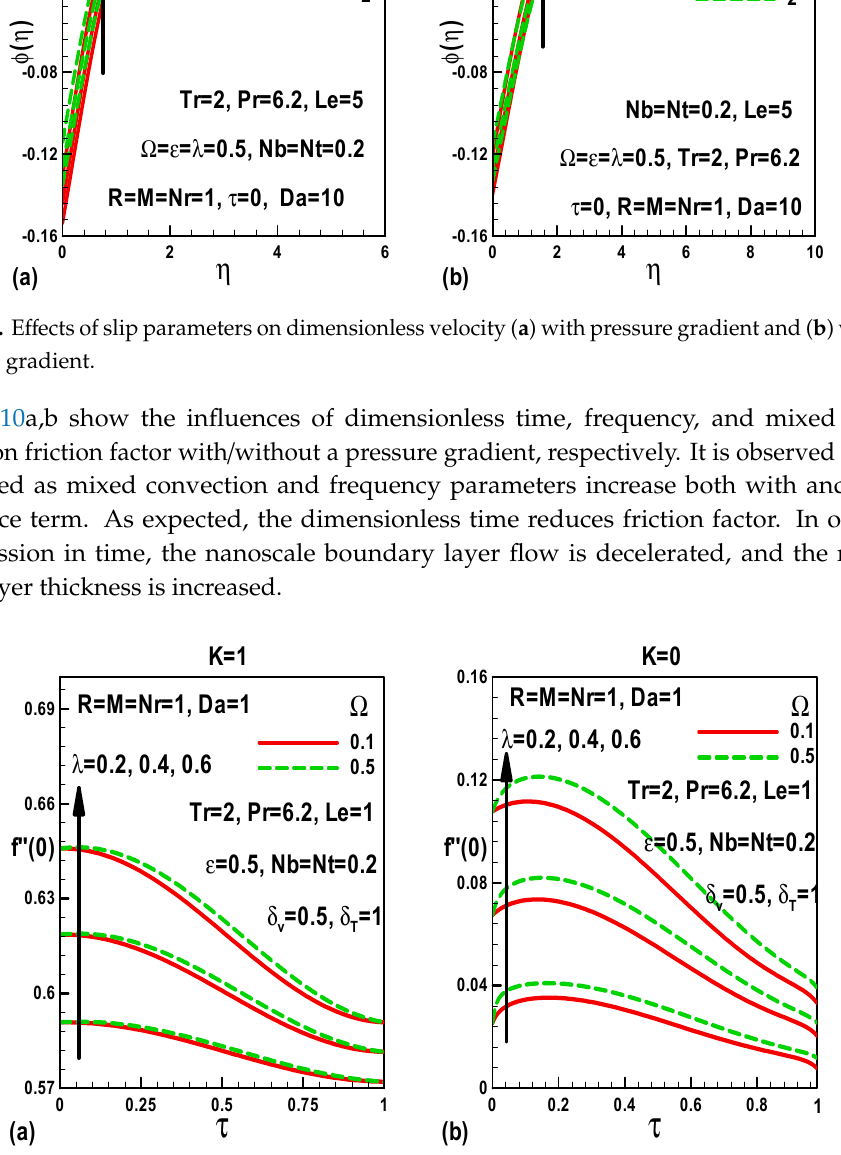
Figure 8. Effects of buoyancy ratio and mixed convection parameters on dimensionless concentration ( a ) with pressure gradient and ( b ) without pressure gradient.